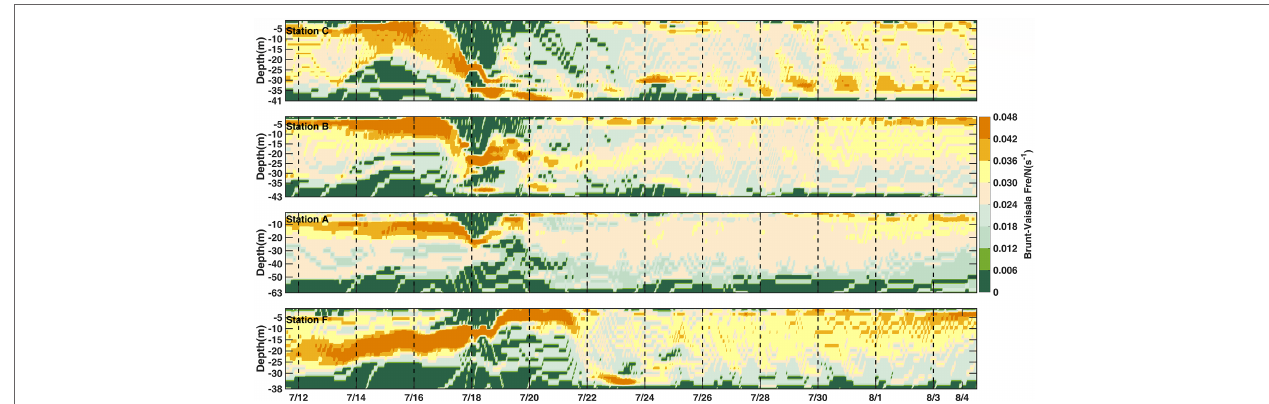
FIGURE 10 | Time series of vertical profiles of Brunt-Väisälä frequency ( N ) at Stations C, B, A, and F from July 12 to August 4. The model simulated hourly density data are used in the